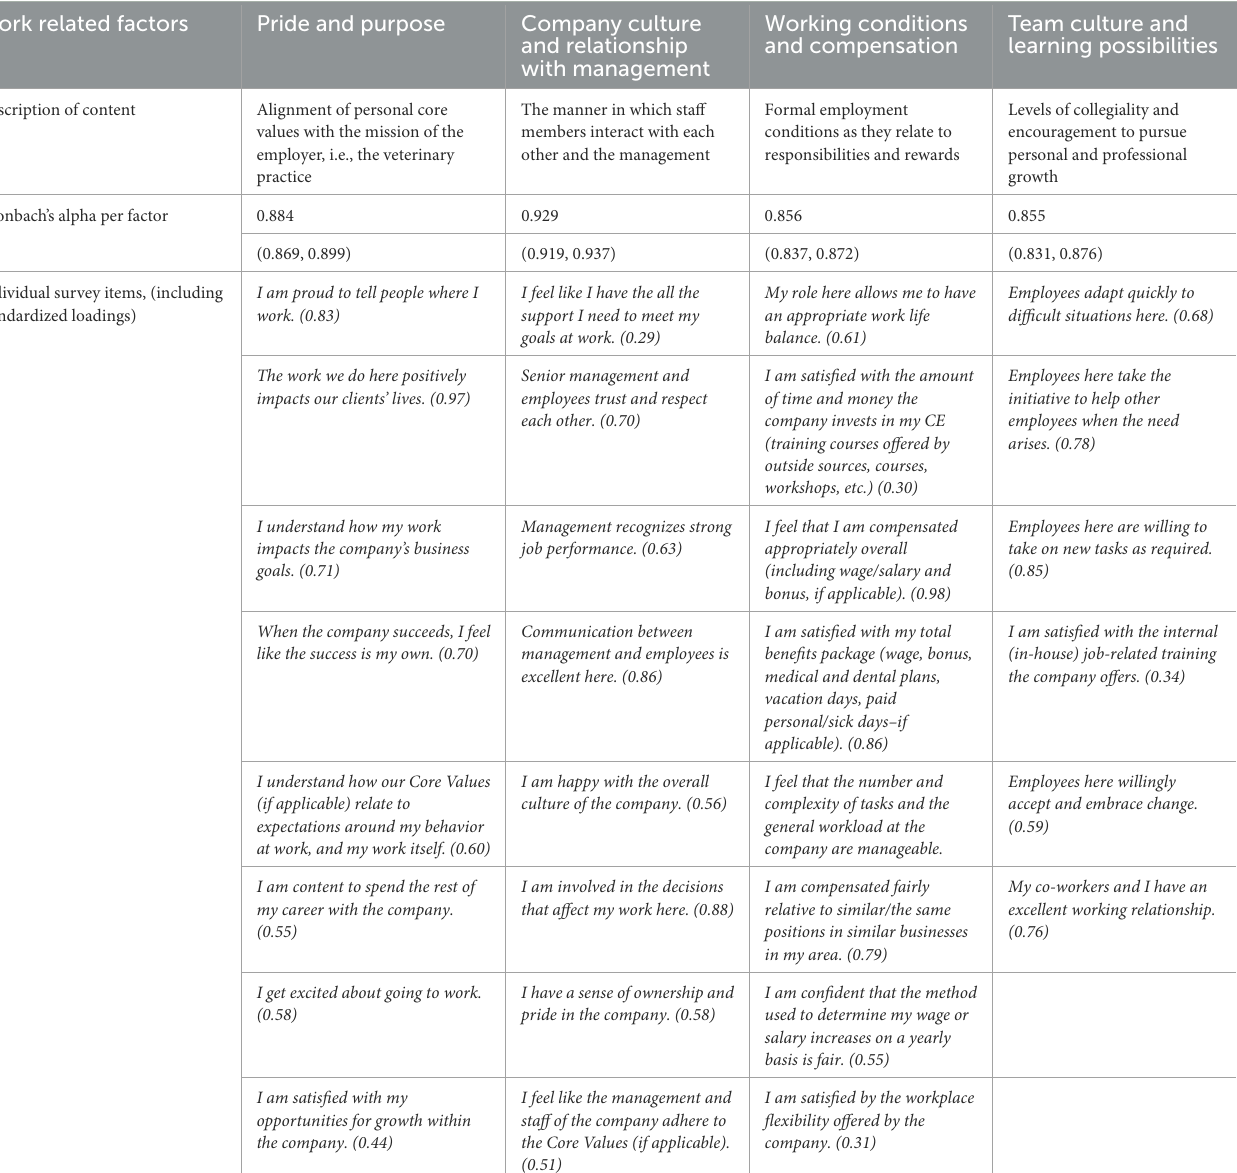
TABLE 1 Multiple correspondence analysis (MCA) calculated factors, identifying the grouping of statements with similar agreement profiles, with factors labeled to encompass the collection of statements